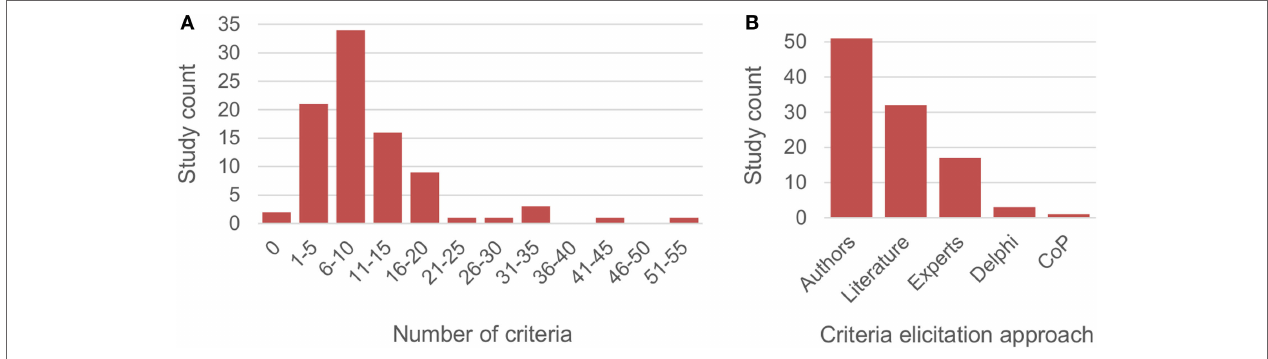
FiGURe 7 | Criteria results from the review . (A) Distribution of criteria number used in the reviewed studies. (B) Distribution of criteria elicitation approaches adopted in the reviewed